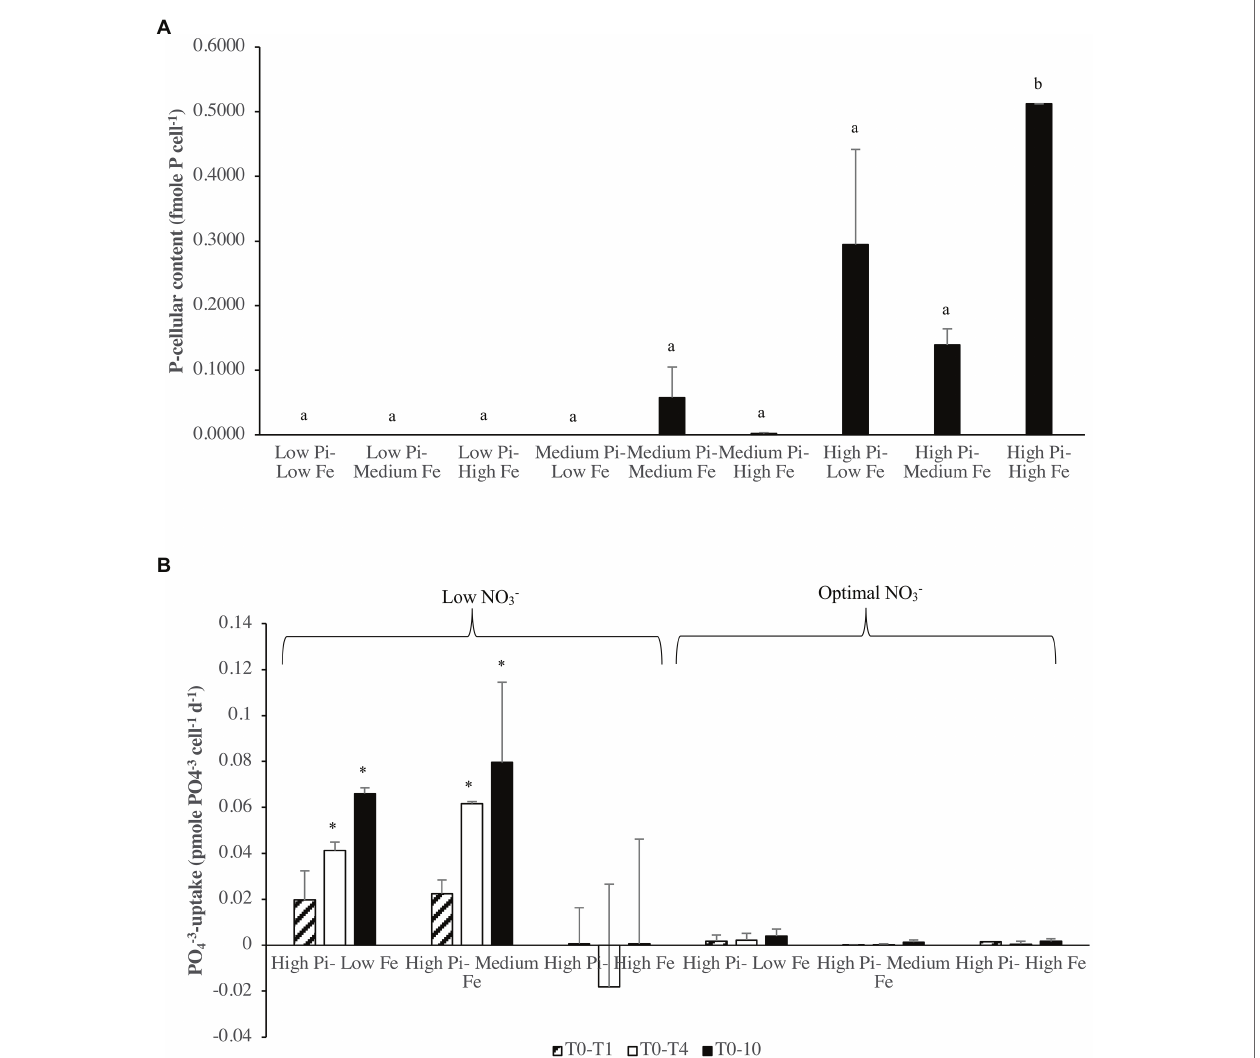
FIGURE 6 | (A) P-cellular content (fmole P cell − 1) under N 2 -fixing conditions in Halothece sp. PCC 7418, at